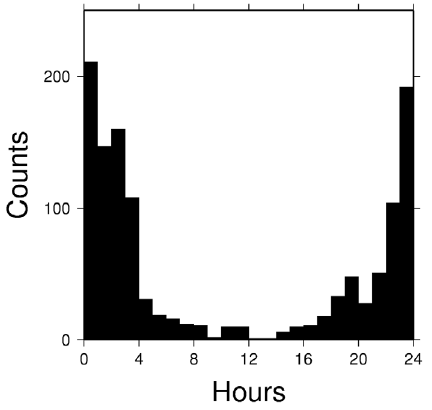
Figure 9. Histogram of the hourly distribution (UTC time = local time – 1) of the seismicity classified as “other non-tectonic sources”. Events during the night hours are strongly prevailing.